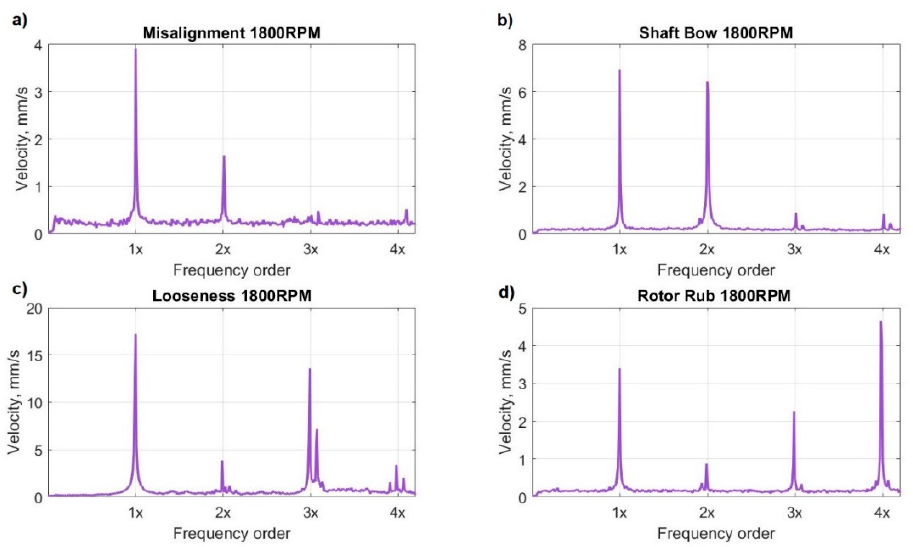
Figure 3. Typical experimental velocity spectrum plots from data at 1800 RPM, at B3 location. ( a ) Misalignment; ( b ) Shaft bow; ( c ) Looseness in pedestal; ( d ) Rotor rub.